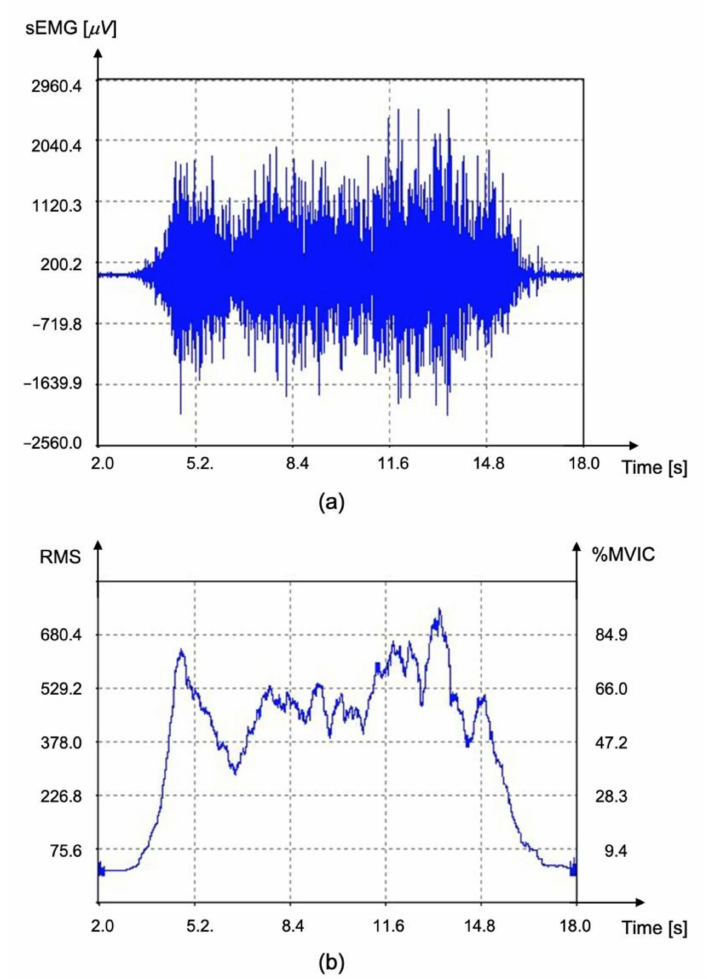
Figure 9. Derivation of RMS and %MVIC: ( a ) sEMG values of original, and ( b ) converted RMS and %MVIC in the time